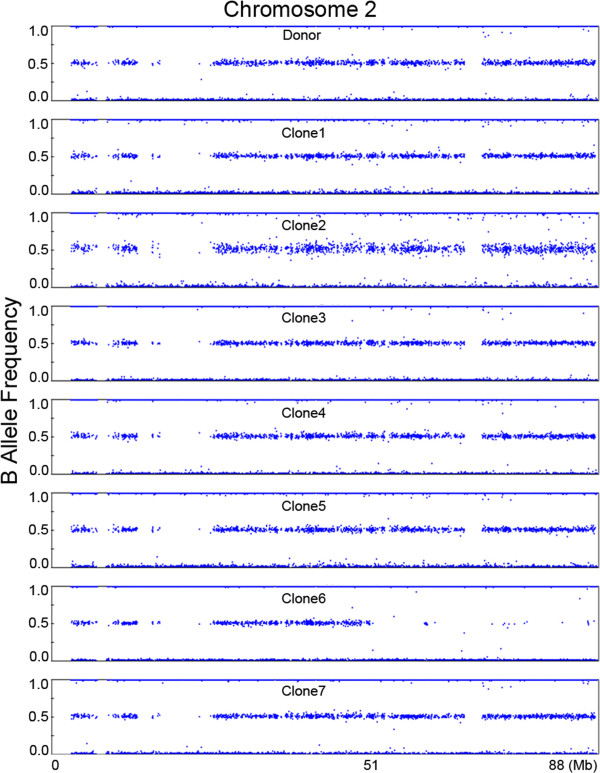
Example of the LOH event in clone-6. A 37-Mb de novo LOH event was identified on the distal end of chromosome 2 in clone-6 that was not detected in the donor or other clones. The X-axis represents genomic position (Mb), and the Y-axis represents B-allele intensity.